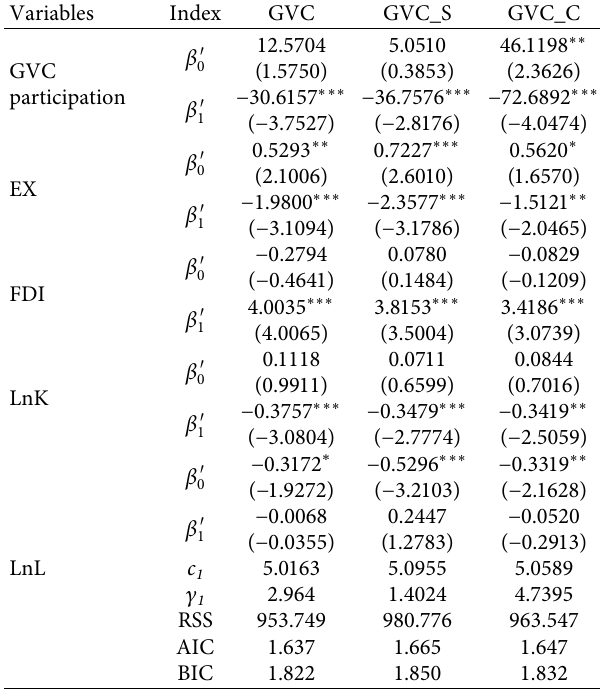
Table 4: Regression